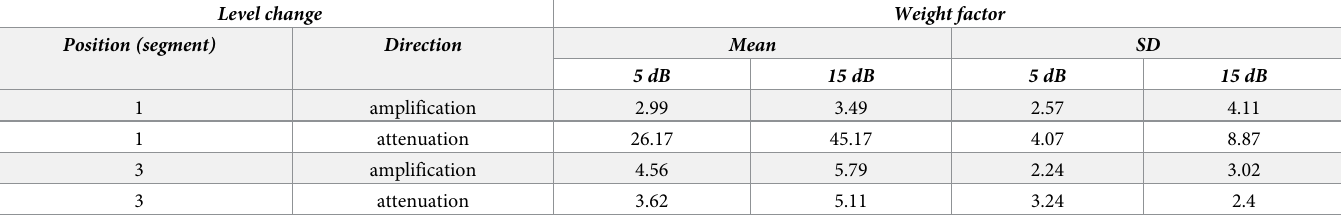
Table 2. Experiment 1. Geometric means and standard deviations of the weight factors for the different positions, directions, and magnitudes of level change in Experi- ment 1. N = 8. Level change Weight factor Position